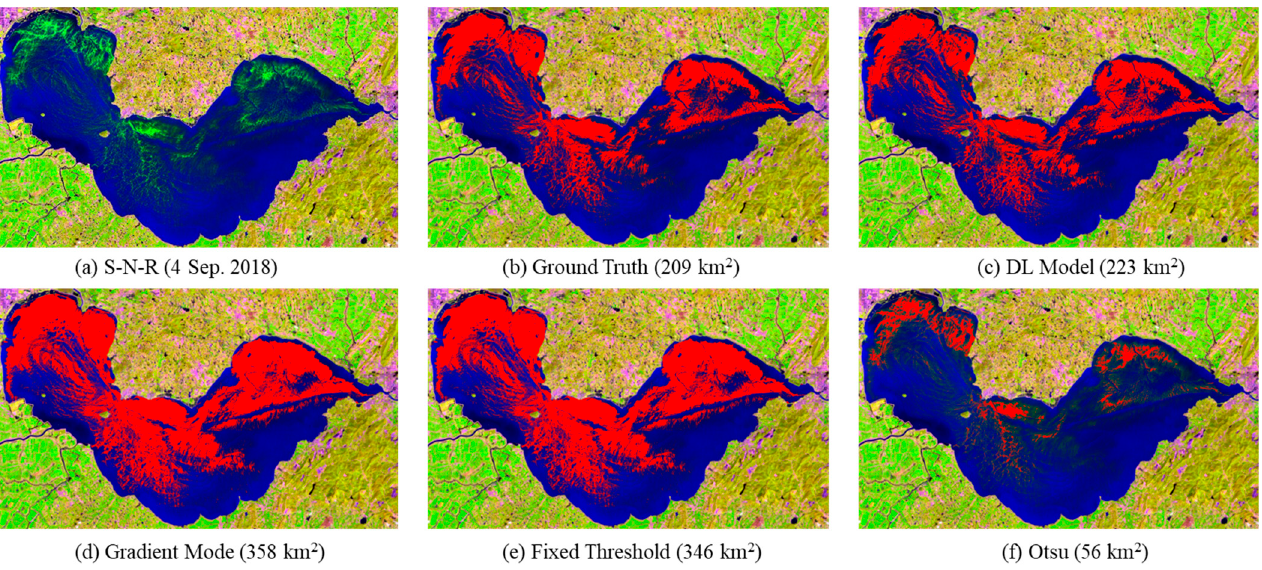
Figure 9. Prediction results of CyanoHABs in Chaohu Lake (4 September 2018), the numbers in brackets in b–e represent the area of the extracted CyanoHABs. ( a ) the original false color synthetic S − N − R) image, ( b ) extraction result of visual interpretation (‘Ground Truth’) ( c ) extraction result of CyanoHABs from DL model, ( d ) extraction result of CyanoHABs by the gradient mode method, ( e ) extraction result of CyanoHABs by the fixed threshold method, ( f ) extraction result of CyanoHABs by the Otsu method. R: red; N: near infrared; S: shortwave